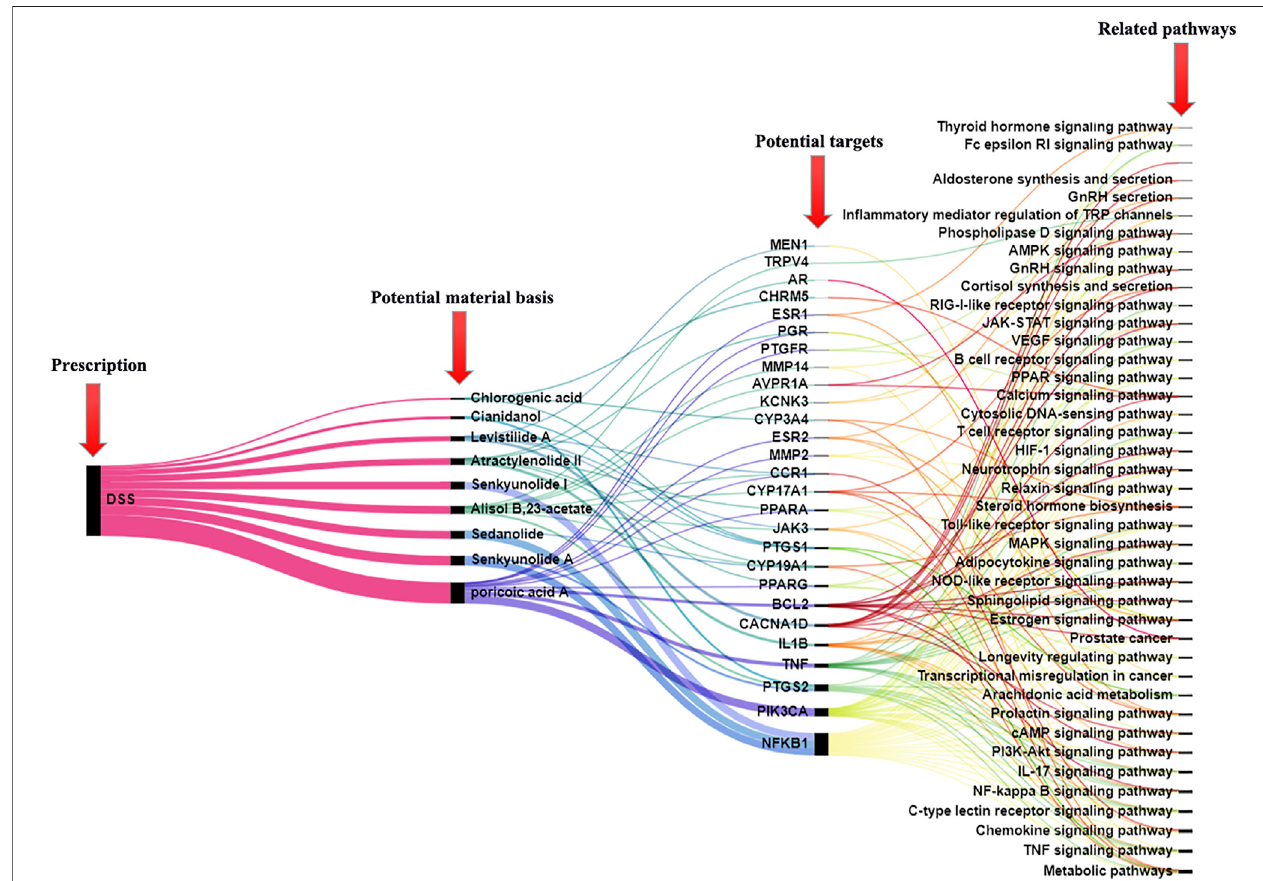
FIGURE 6 | Connection diagram of prescription – potential material basis – potential targets-related pathways. The line thickness represents the degree of connection.